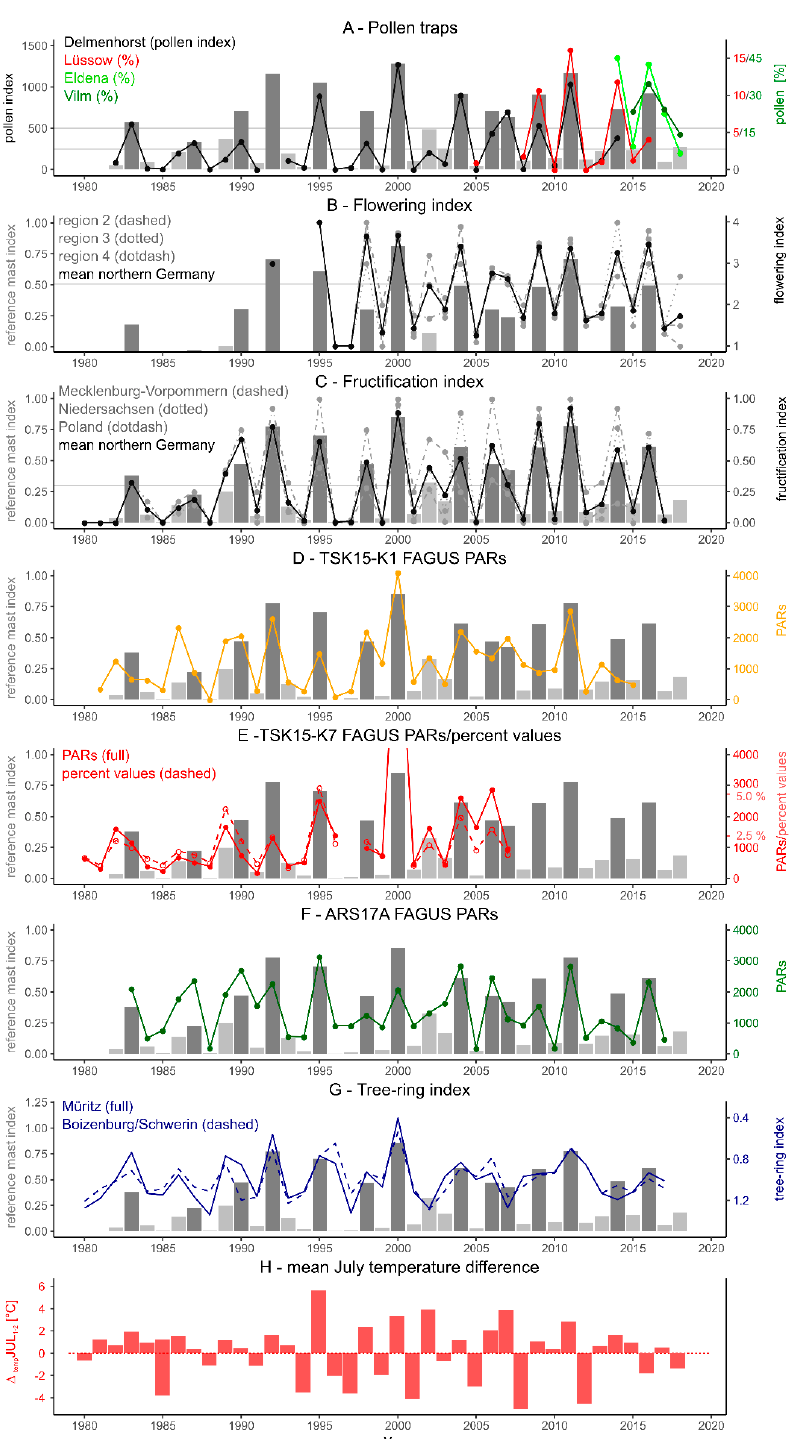
Figure 3. Pollen and forest monitoring data for beech ( A – C ), annual pollen deposition in three sediment cores ( D – F ), ring width index from the Müritz and Boizenburg/Schwerin composite ( G ) and difference in mean July temperature one year ago minus mean the value two years ago ( H ). Grey bars: reference mast index, dark bars indicate supposed pollen mast years. The pollen index ( A ) for each year is the sum of all daily means of F agus pollen grains per cubic metre of air. Flowering and fructification index ( B , C ) are assigned by forest monitoring. The reference index is calculated as a mean of pollen, flowering and fructification index. Pollen accumulation rates (PARs) ( D – F ) are given in pollen grains cm − 2 yr − 1